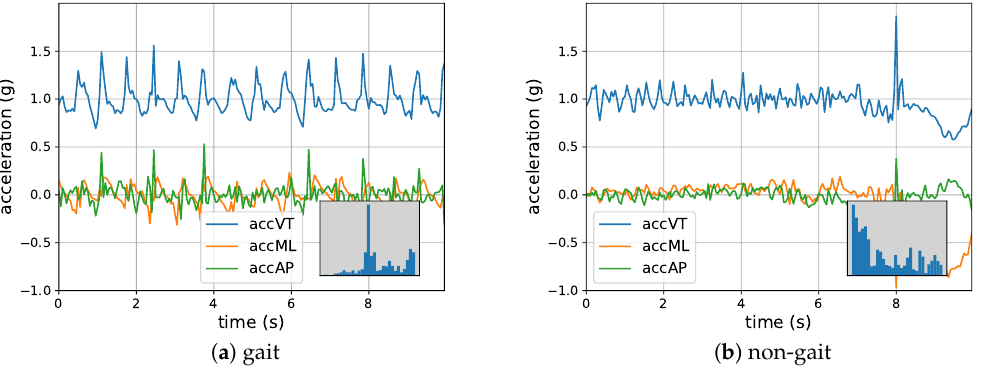
Figure 9. ( a ) An example of a 10-s data sample included in the training and testing set and ( b ) an example of a data sample excluded in Experiment 5 due to the low dominant frequencies in the VT-axis. In the bottom-right corners, histograms of the VT-frequencies up to 3 Hz are depicted. Both examples were included in the first 4